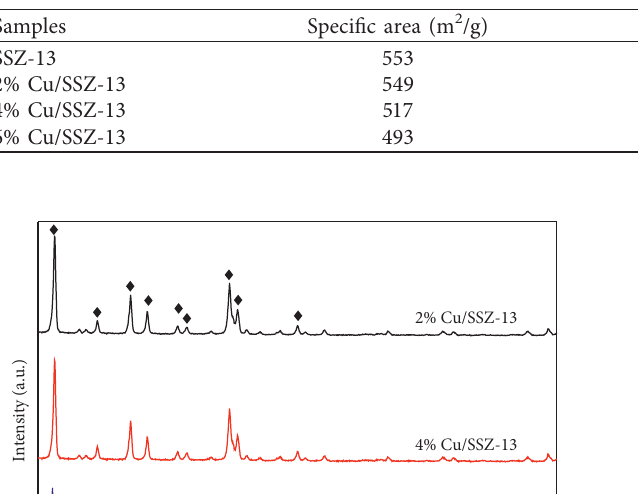
Table 1: Physical characteristics of Cu/SSZ-13 zeolites.